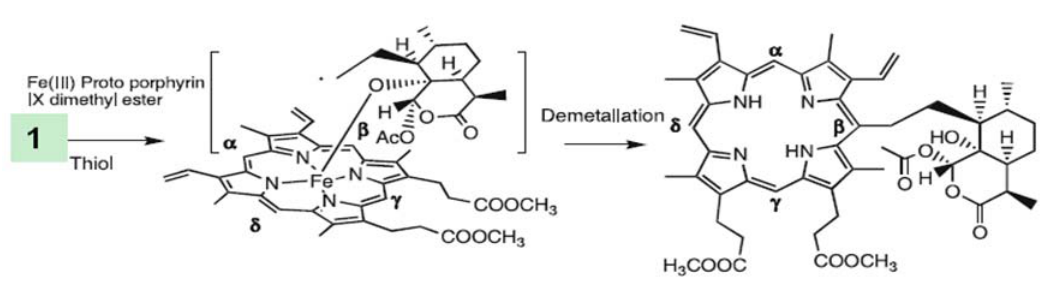
Figure 6. Alkylation of a heme model (the dimethyl ester of heme) by a primary carbon centered radical derived from bioactivation of artemisinin ( 1 ). Adducts were also obtained from α and δ carbon atoms